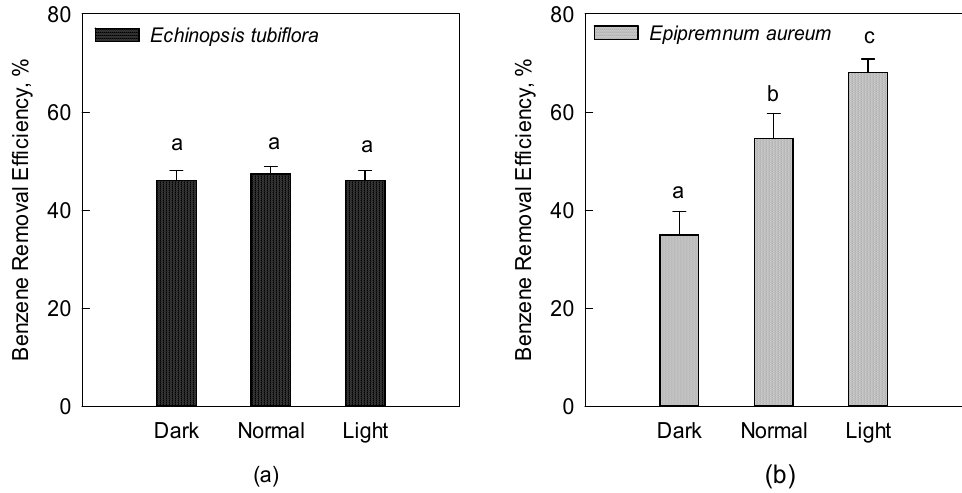
Figure 4. Benzene removal efficiency of Echinopsis tubiflora ( a ) and Epipremnum aureum ( b ) under normal conditions (12 h light and 12 h dark), light conditions (24 h light), and dark conditions (24 h dark). The error bar indicates the standard deviation for three replicates. The different letters above columns indicate the significant difference under different light conditions (Duncan test, P < 0.05).